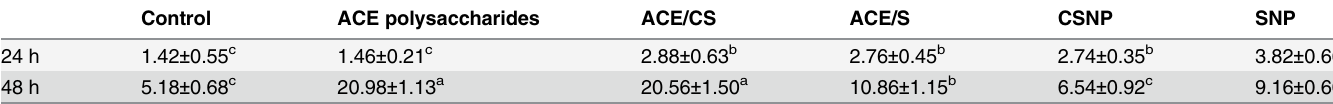
Table 1. Cell cycle analysis for Hep G2 apoptosis induced by ACE polysaccharides, ACE/CS and ACE/S for 24 h and 48 h.